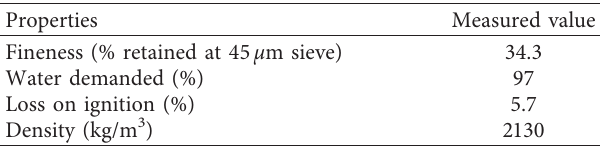
Table 2: Physical properties of fly ash.